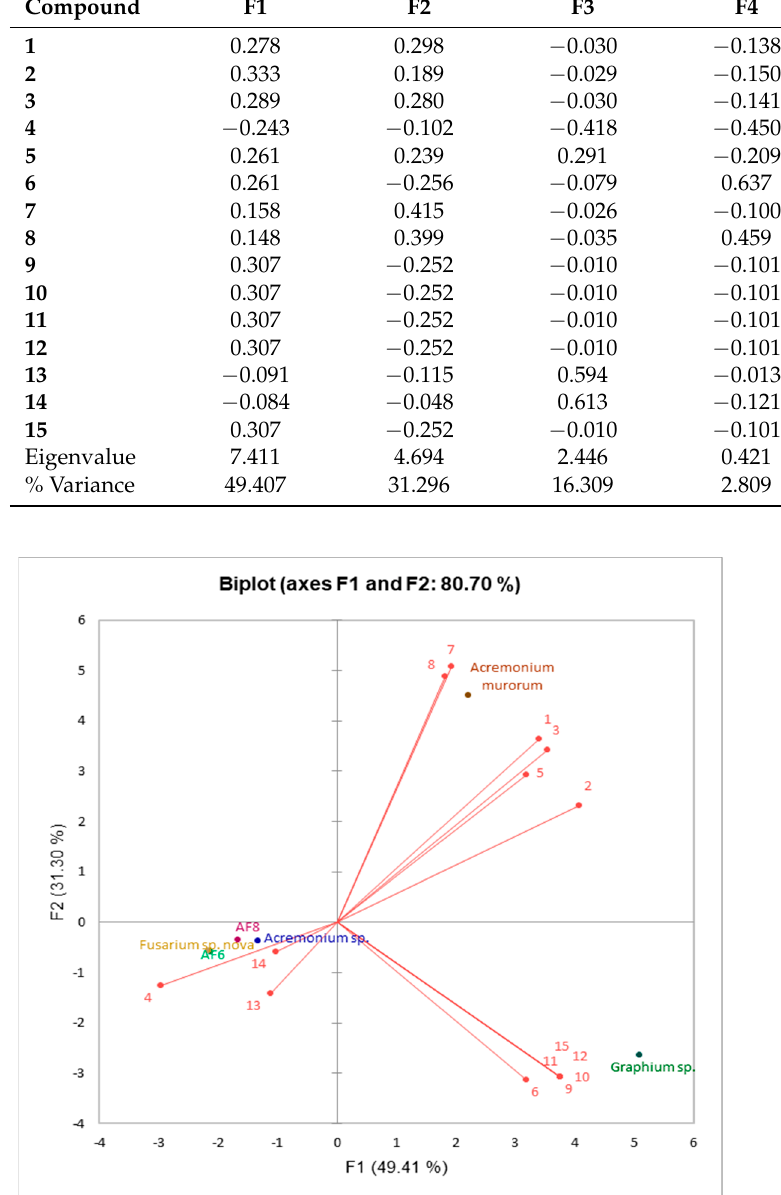
Figure 3. Principal component analysis (PCA) plot of the scores (volatile compounds emitted by symbionts) loading by dotes and loadings (symbionts) indicated by lines based on the first and second principal components. Numbers represent the compounds 1 to 15 in Table 1.